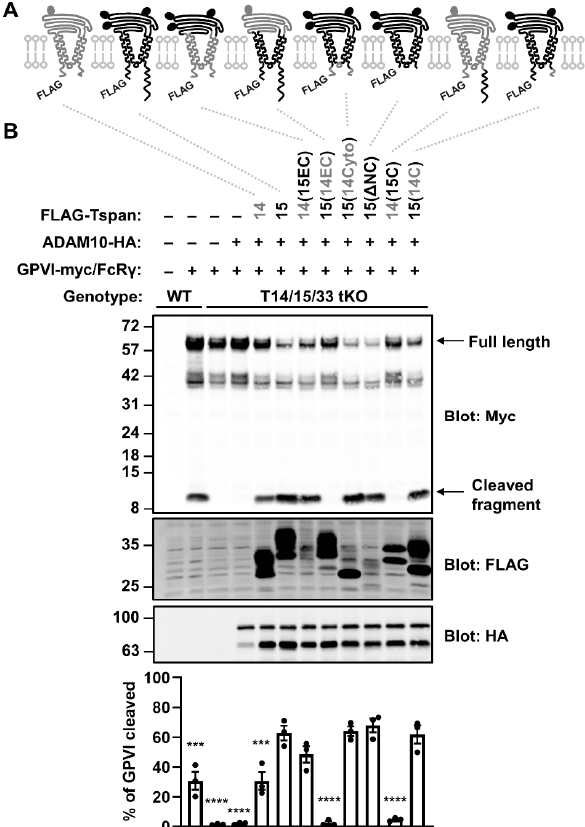
Figure 4. The extracellular region of Tspan15 is required for efficient GPVI cleavage and the C-terminus is inhibitory. ( A ) Schematic of N-terminally FLAG-tagged Tspan14 (grey) and Tspan15 (black) chimeras, where the entire extracellular region (EC), cytoplasmic domain (Cyto) or C-terminal tail (C) were exchanged. Truncation of both the N- and C-terminal tails is indicated by Δ NC. Ovals represent N-glycosylation sites. ( B ) Wild-type (WT) HEK-293T cells were transfected with expression constructs for C-terminally Myc-tagged GPVI and FcR γ (+) or empty vector (–). In addition to GPVI and FcR γ , Tspan14/15/33 triple knockout (T14/15/33 tKO) HEK-293T cells were co-transfected with HA-tagged ADAM10 alone, or in combination with FLAG-tagged Tspan14 and Tspan15 constructs described in panel A. Cells were lysed in 1% Triton X-100 followed by Western blotting with anti-Myc, anti-FLAG and anti-HA antibodies (top panels). The percentage of cleaved GPVI was calculated (lower panel). Error bars represent the standard error of the mean from three independent experiments. Data were arcsine-transformed and statistically analyzed using a one- way ANOVA followed by a Dunnett’s multiple comparison test, compared to T14/15/33 tKO cells transfected with wild-type Tspan15 and ADAM10 (***, p < 0.001; ****, p <